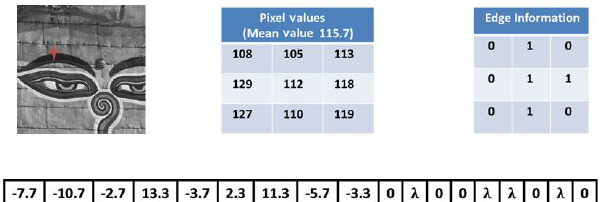
Fig. 3 Feature vectors.